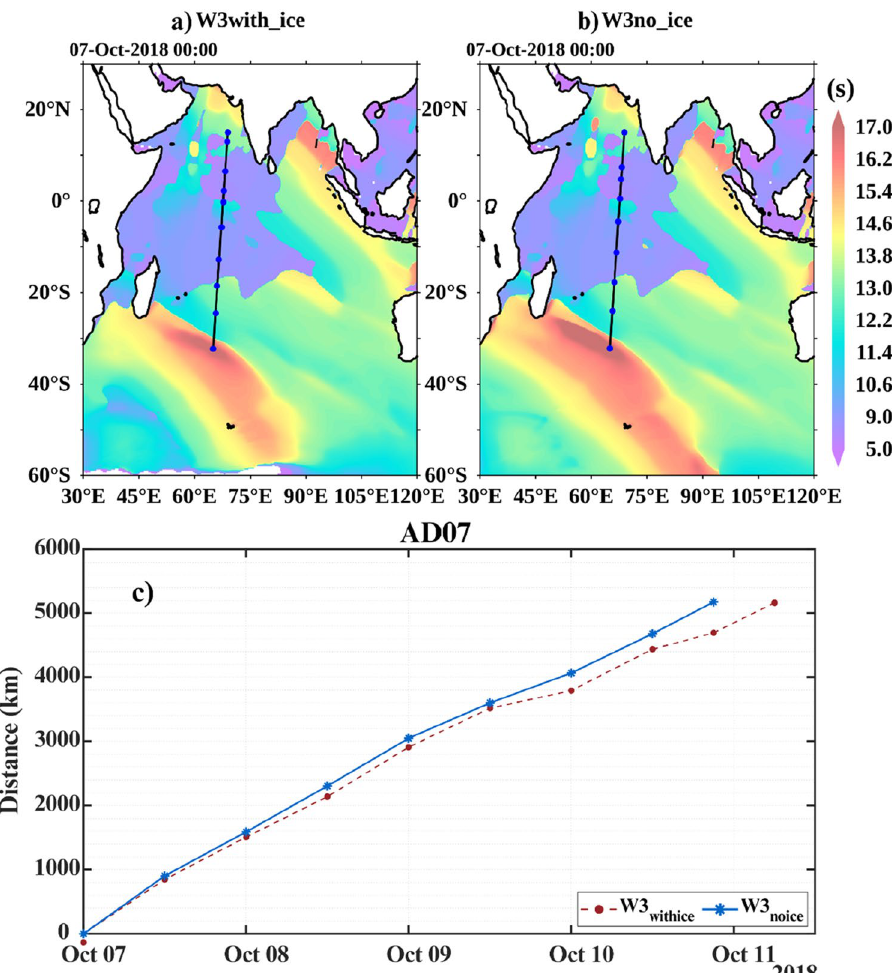
Figure 7. Distance line of swell from SO to AD07 mooring location from 07-Oct-2018 00 h with blue dots representing 12-h marks in ( a ) W3 with_ice and ( b ) W3 no_ice simulations and ( c ) shows the distance versus time